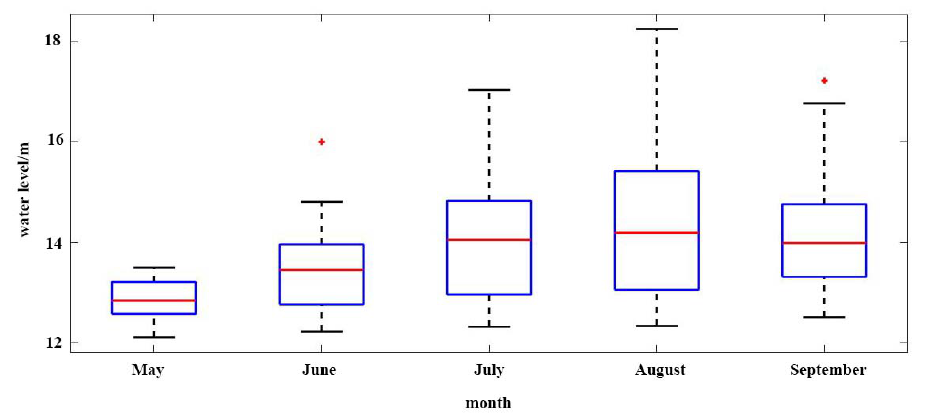
Figure 6. Box plot of the water levels from May to September for Longgan Lake (meters above sea level, reference to Wusong